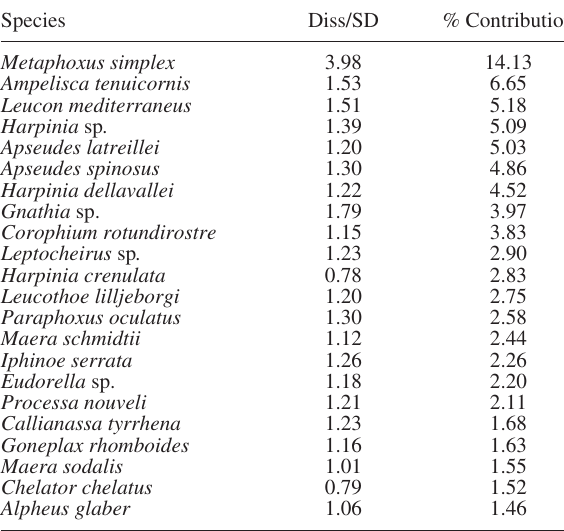
Table 2. – Summary of SIMPER results: list of the species that account for 80% of total abundance at S1 and S2, dissimilarity in- dex (Diss/S) between sites and % contribution to total crustacean abundance.